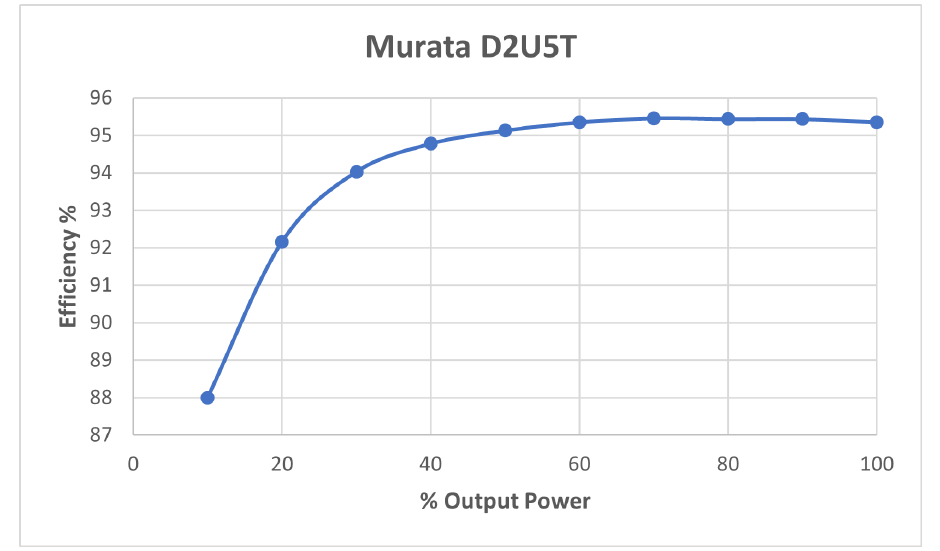
The elevator rectifier efficiency curve is presented in Figure A1.